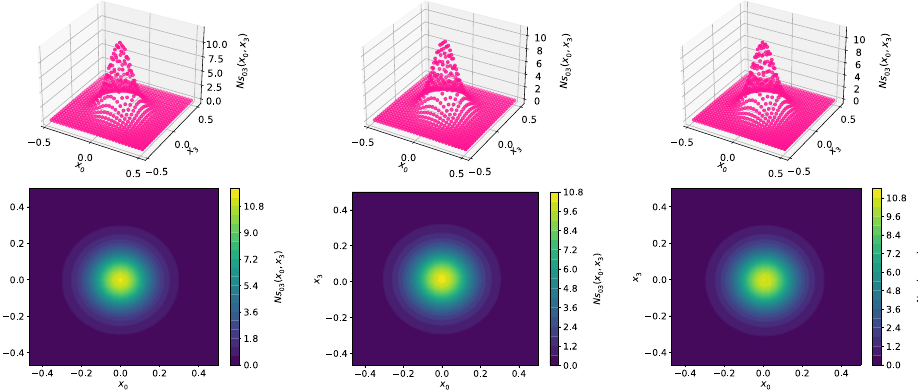
Figure 3. We display as a function of x 0 /l and x 3 /l the profiles obtained by integrating over x 1 and x the action density of the configuration with l 2 to right: SU(3) , SU(5) and SU(8) .